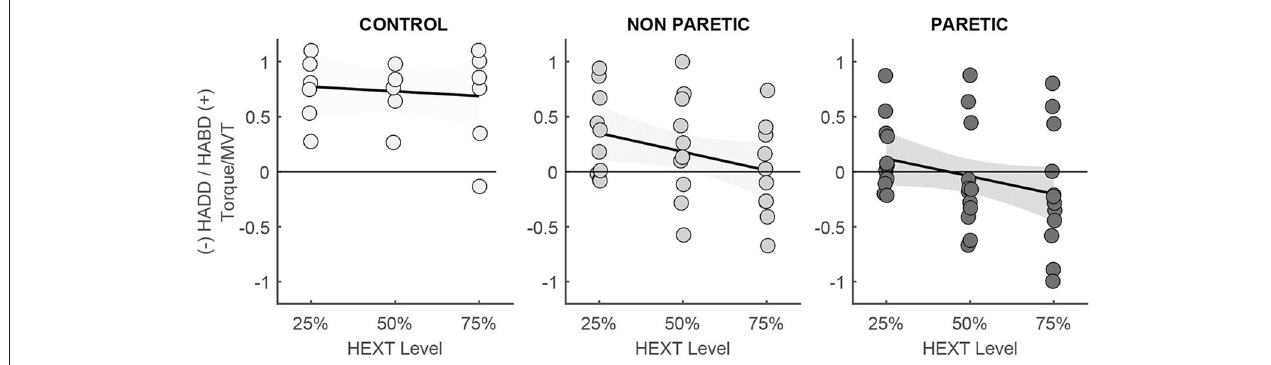
FIGURE 4 | Individual data and linear regression lines to illustrate the relationship between hip extension/adduction. The flat regression line and lack of significant correlation in control participants indicates independence between hip extension and abduction. The relationship between hip extension and abduction/adduction is seen in the paretic extremity and to a lesser degree in the non-paretic